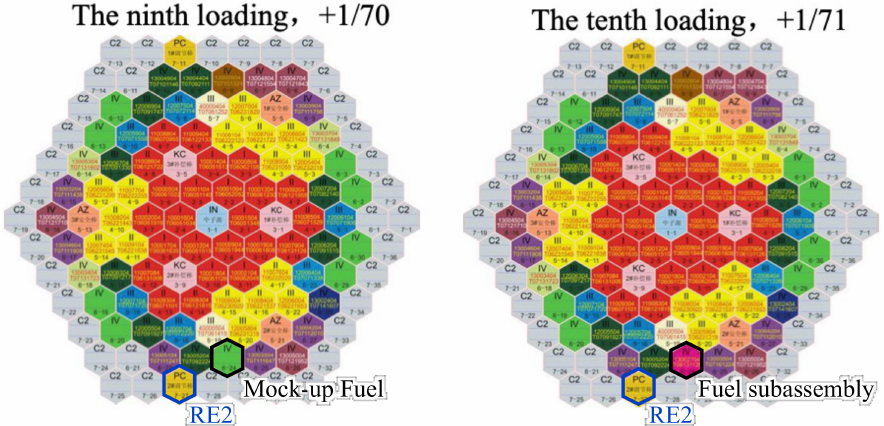
Figure 2. Core-loading pattern with fuel subassemblies and mock-up fuel subassemblies. ( Left : 71 fuel subassemblies and 8 mock-up fuel subassemblies; Right : 72 fuel subassemblies and 7 mock- up fuel subassemblies). Bright green colored positions are for fuel subassemblies. Colored positions with number I to IV are for fuel SAs. AZ, KC and PC are positions for control rods. IN is position for neutron source SA. C2 is for SS